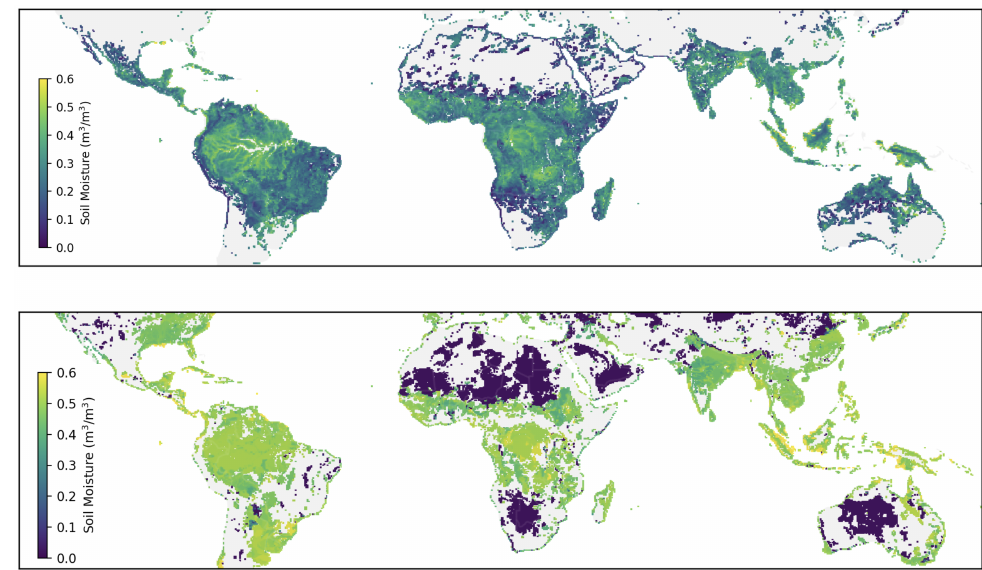
Figure 22. SMAP soil moisture values associated with two classes of “low-quality” flags, the upper panel were included in training, the lower panel were